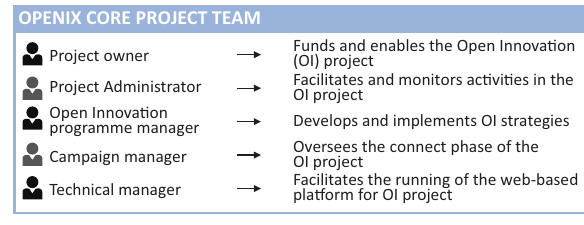
FIGURE 1: List of participants and their